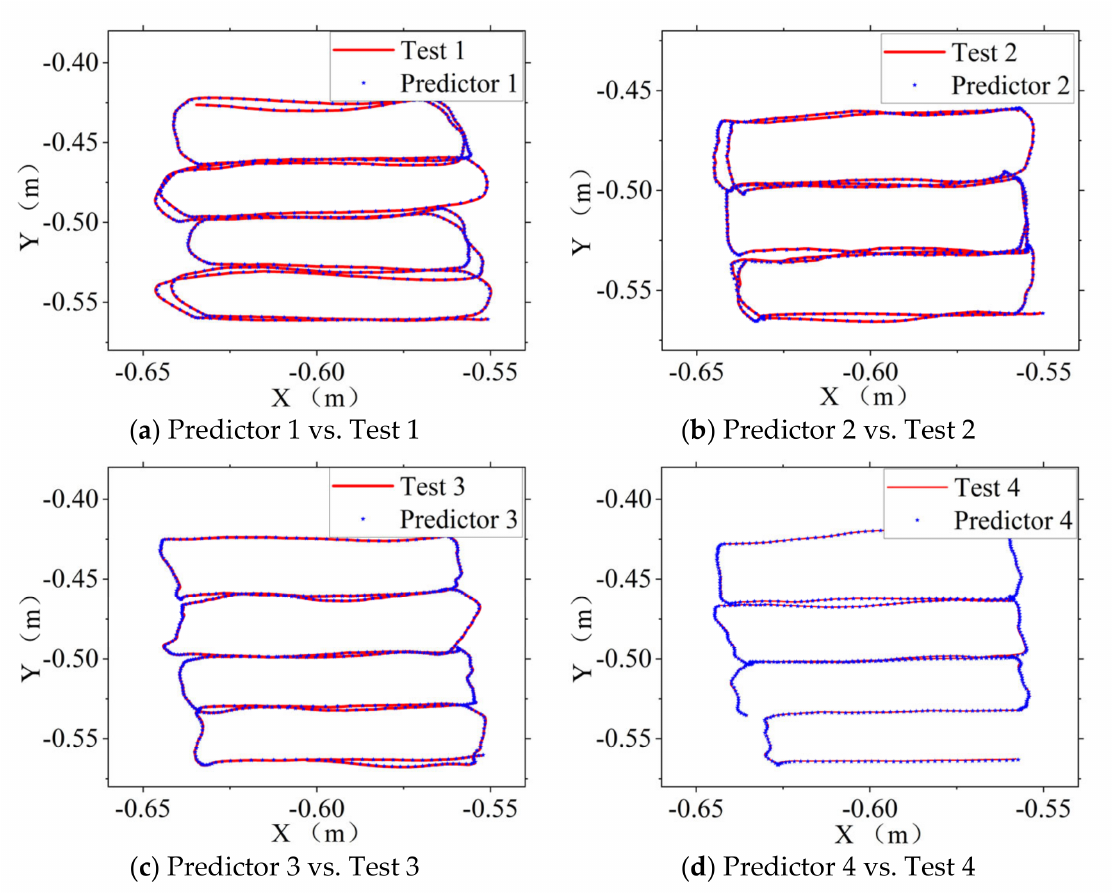
Figure 3. Trajectory curve comparisons of predications and test data sets.